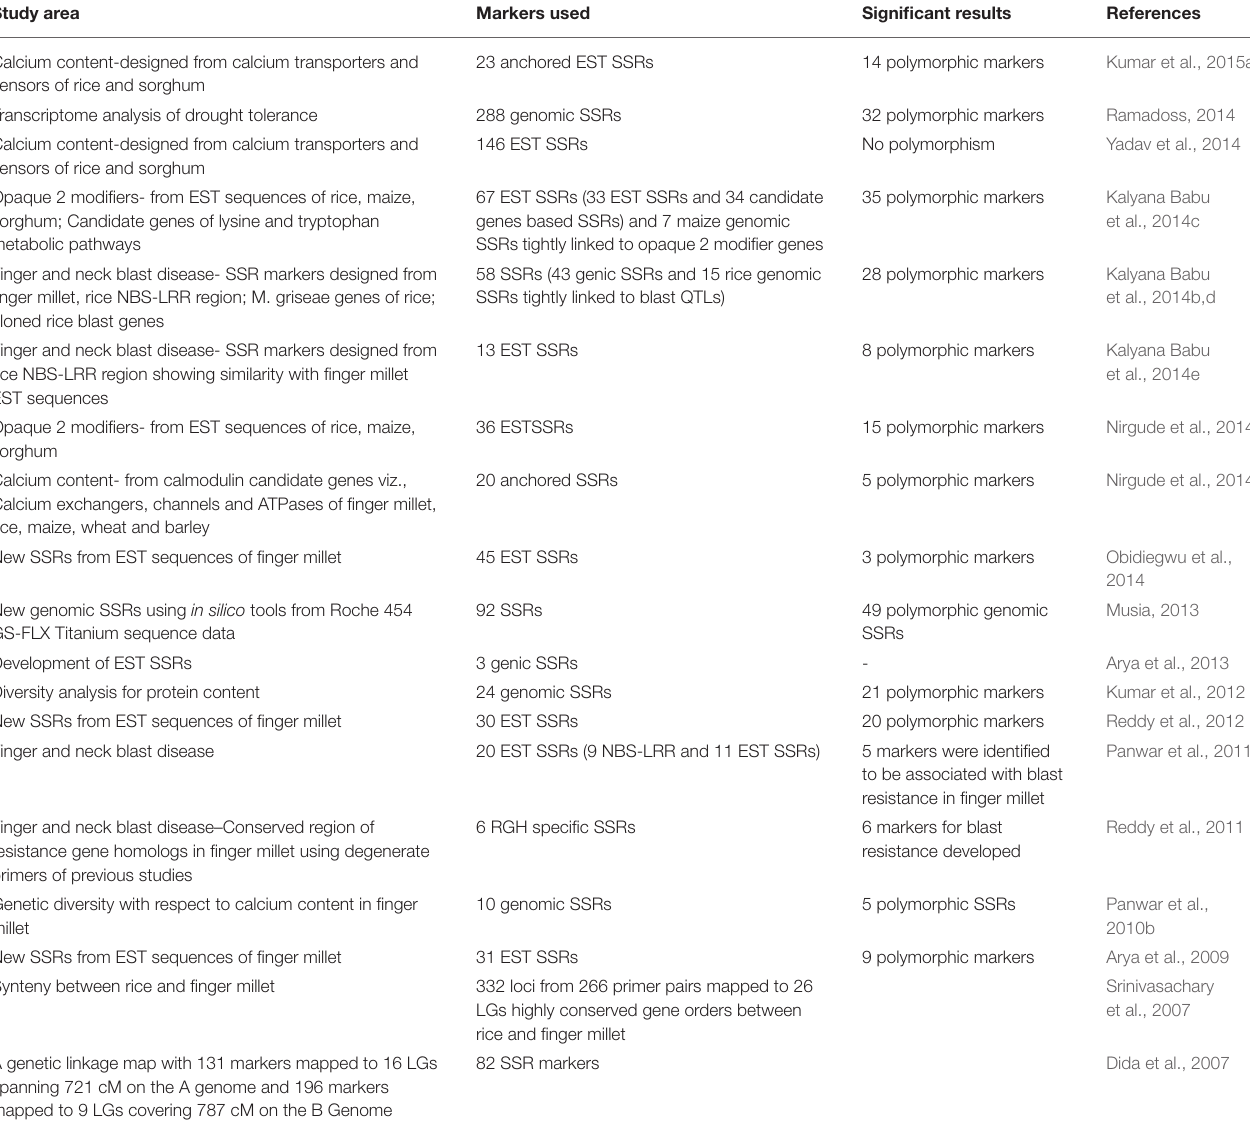
TABLE 1 | Studies on development of genomic and genic SSRs in finger